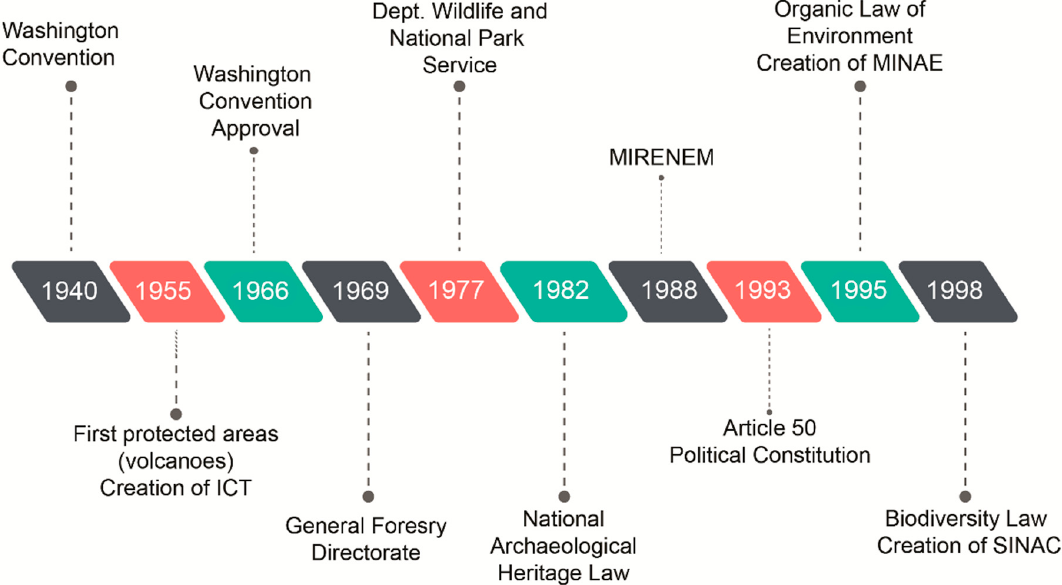
Figure 9. Brief summary of environmental policies that favored geoheritage in Costa Rica.